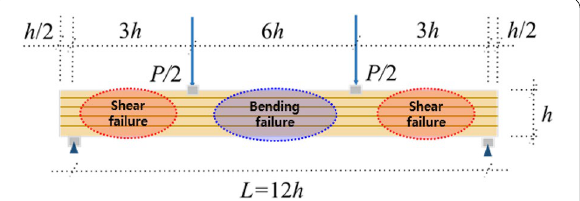
Fig. 8 Bending and rolling shear failure in shear test. h thickness of specimen (mm), P load (N), L span of specimen